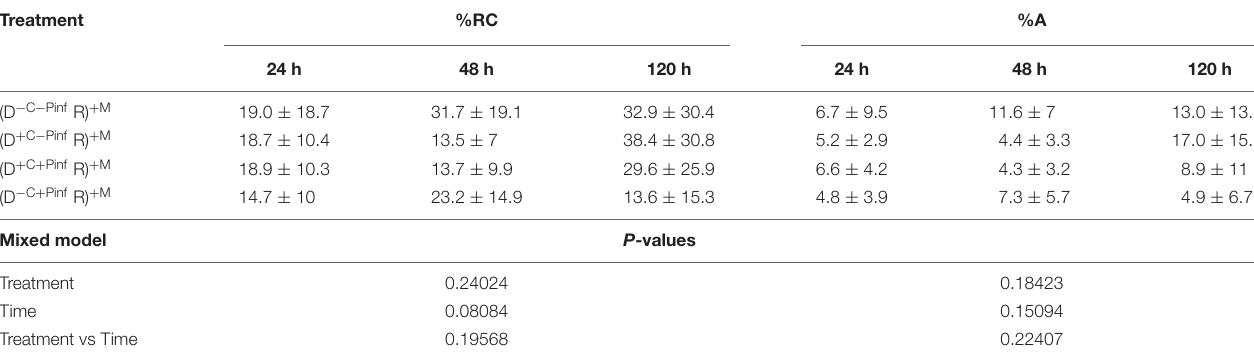
TABLE 2 | Percentage of total roots (% RC) and arbuscules (% A) colonization of the potato receiver plantlets—R (i.e., plantlets grown in the HC) connected to the potato donor plantlets—D (i.e., plantlets grown in the RC) via the extraradical mycelium of R. irregularis MUCL 41833.